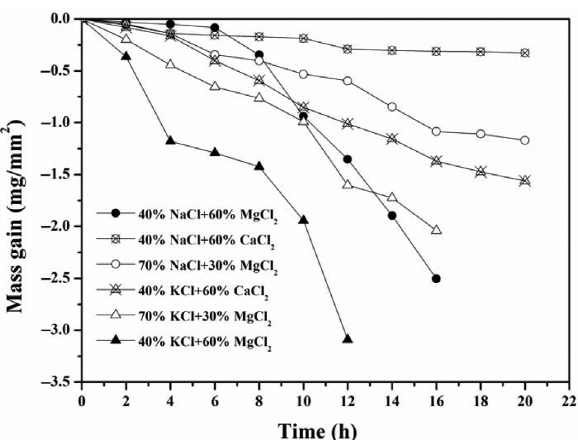
Figure 2: Corrosion kinetics of Inconel 625 in mixtures of molten chloride salts at